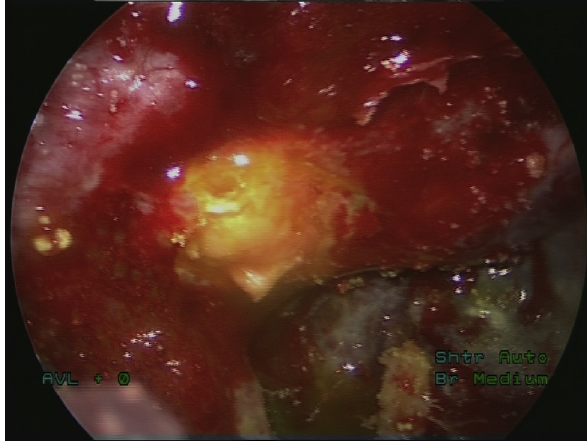
Figure 1 Fluorescein-stained cerebrospinal fluid fistula with a CSF leak, without using a blue light filter.